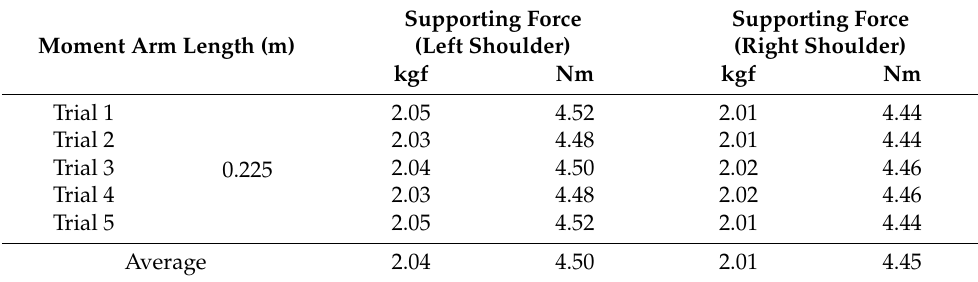
Table 2. The results of the generated torque test of the gravity compensation